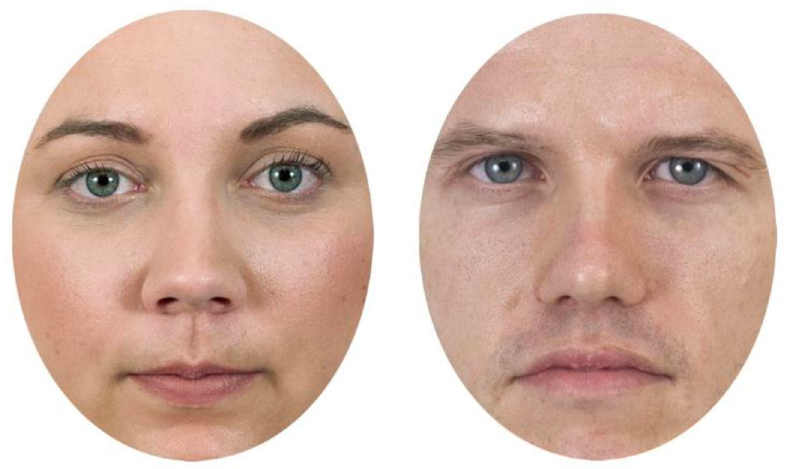
Fig 4. Examples of a female (left) and male (right) face used to produce the stimuli in the complex task (both setups). Note. Faces obtained from Chicago Face Database [41].